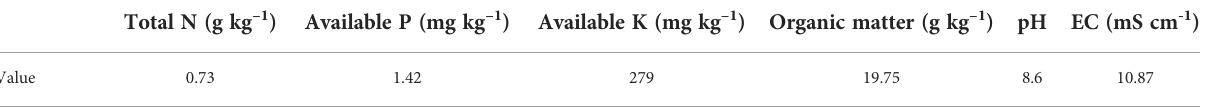
TABLE 1 Chemical composition of soil in saline soils in this study, including Total N (Kjeldahl), Available P (Mehlich), Available K ( fl ame spectrophotometry), Organic matter (Potassium dichromate oxidation volumetric method), pH (electrode method), and EC (1:5).